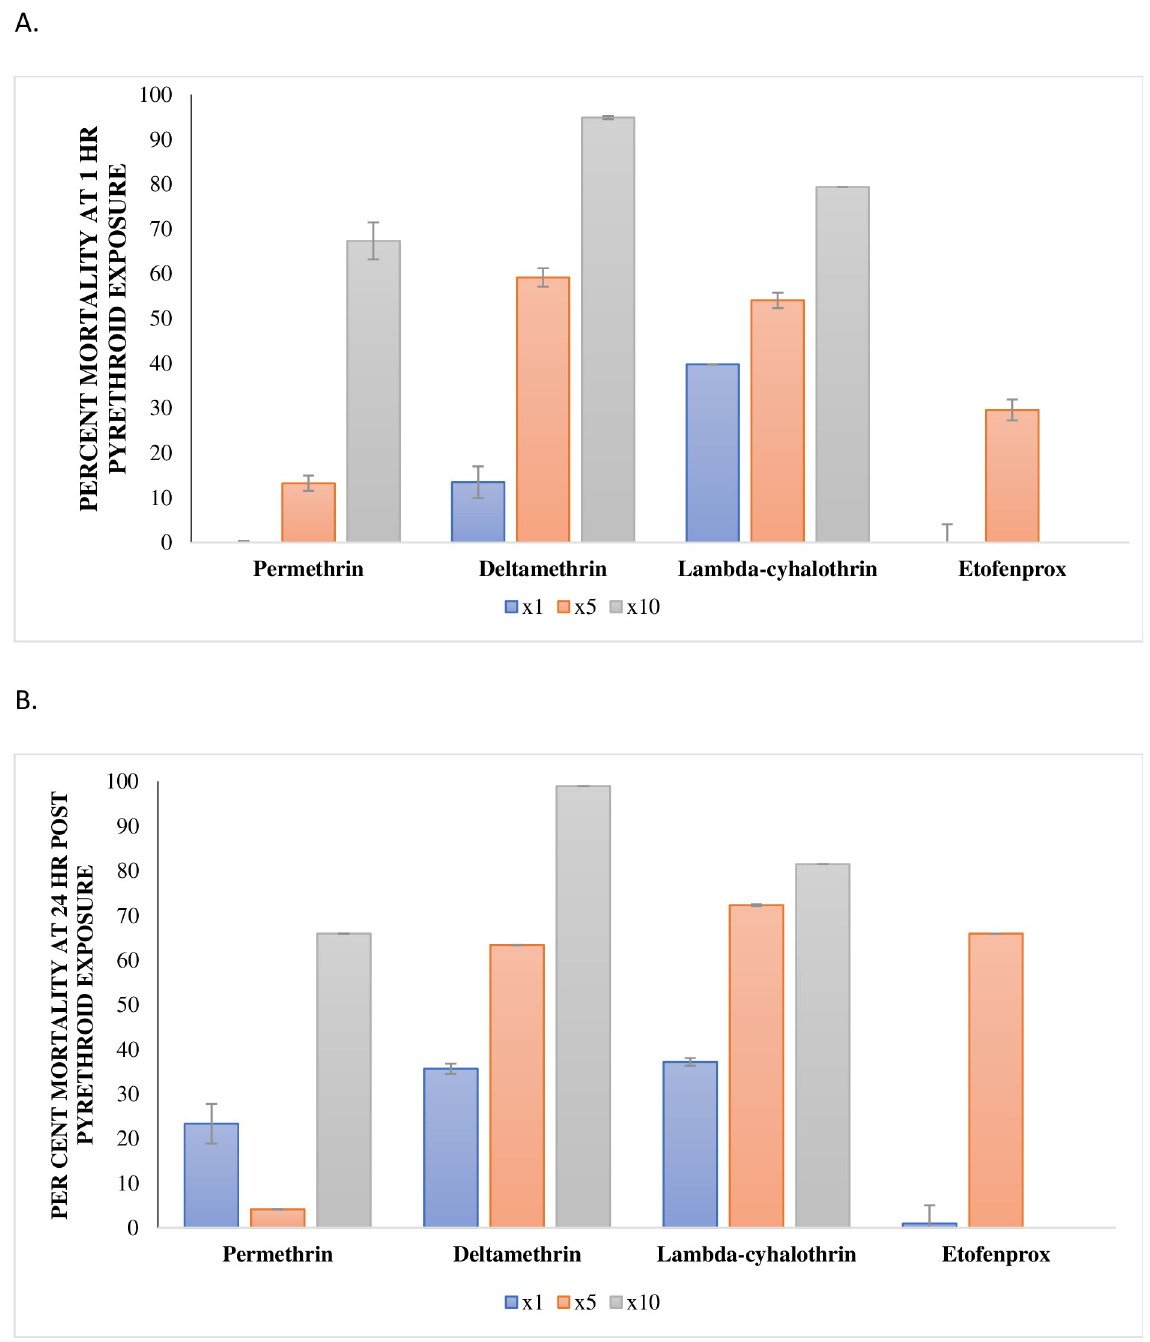
Fig 3. Percentage mortality of St. Catherine Ae . aegypti population exposed to 1x, 5x or 10x Concentrations of Several Pyrethroids. The effect of 0.25%, 1.25% and 2.5% permethrin; 0.03%, 0.15%; 0.3% deltamethrin; 0.03%, 0.15% and 0.3% lambda-cyhalothrin; and 0.5% and